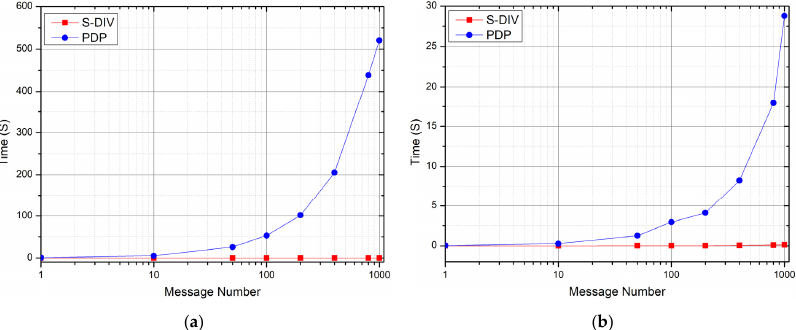
Figure 5. Comparison of verification efficiency between S-DIV and PDP: ( a ) comparison of proof generation; ( b ) comparison of verification.